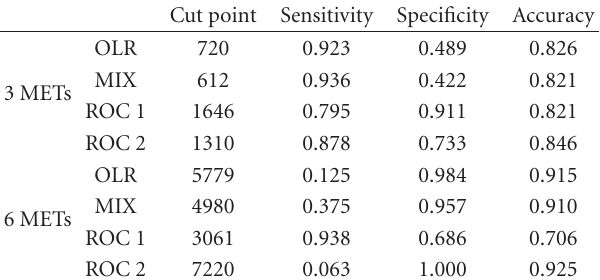
Table 4: The suggested cut points, sensitivity, specificity, and accuracy from the di ff erent statistical analyses. OLR: ordinary linear regression; MIX: mixed model regression; ROC 1: cut point with the highest product of sensitivity and specificity; ROC 2: cut point with the highest